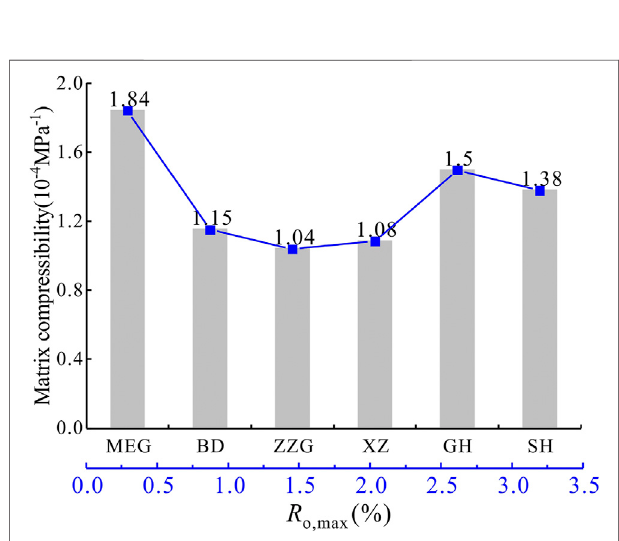
FIGURE5| Characterization ofmatrixcompressibility ofcoal samplesof different coal